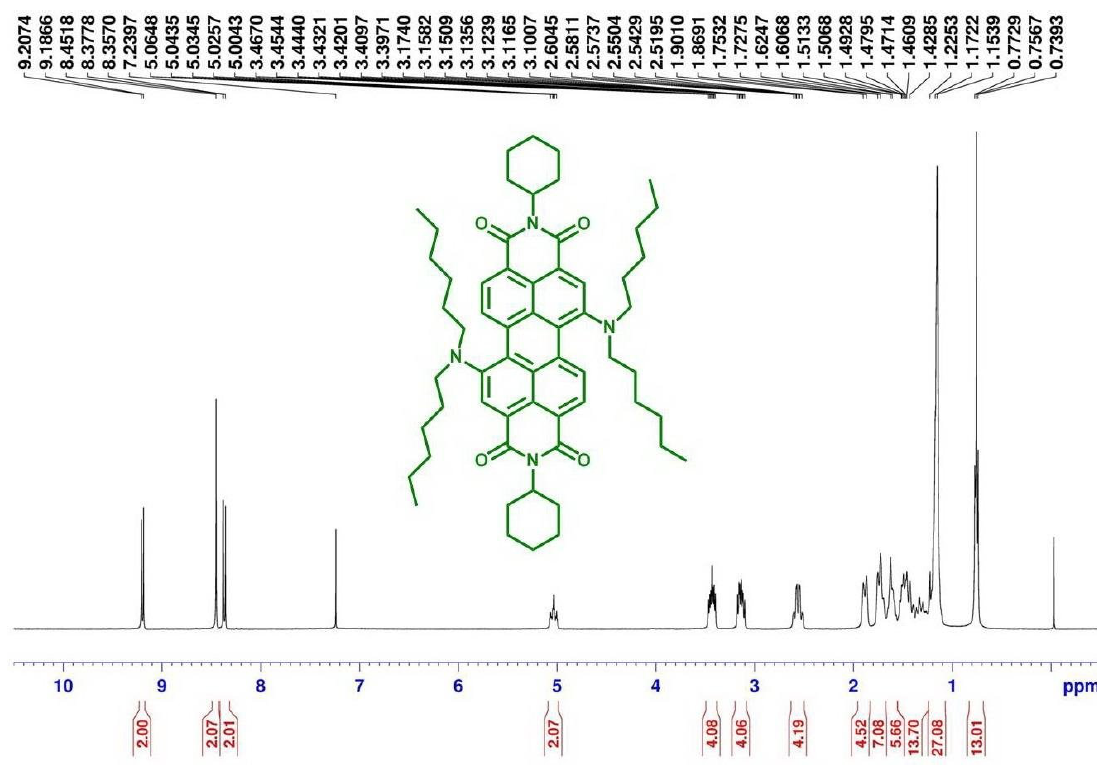
Figure 2. 1 H NMR (400 MHz, CDCl 3 ) spectra of 1a